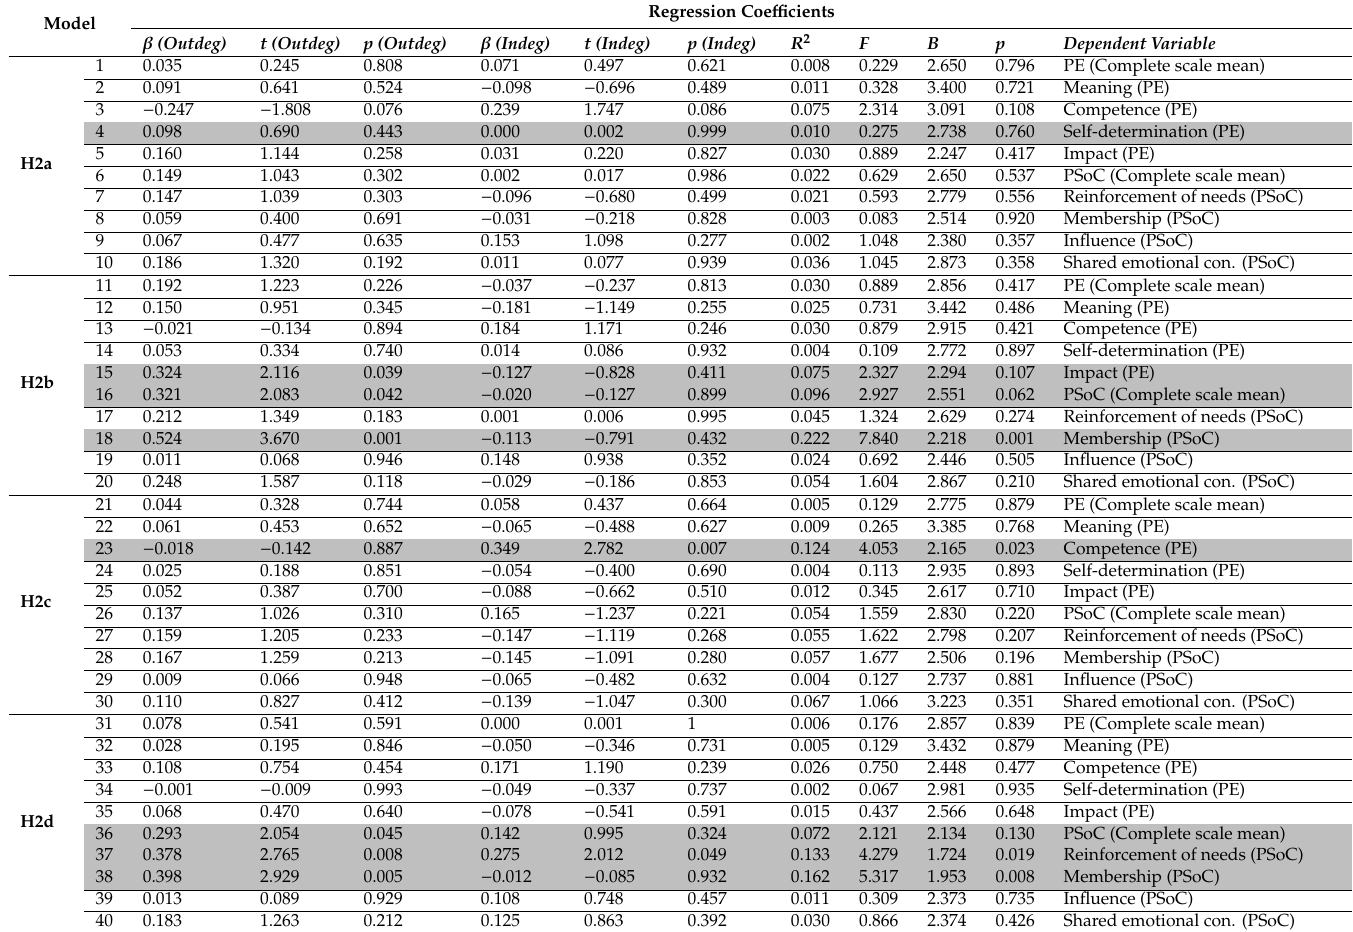
Note: Grey background highlights the models with statistical